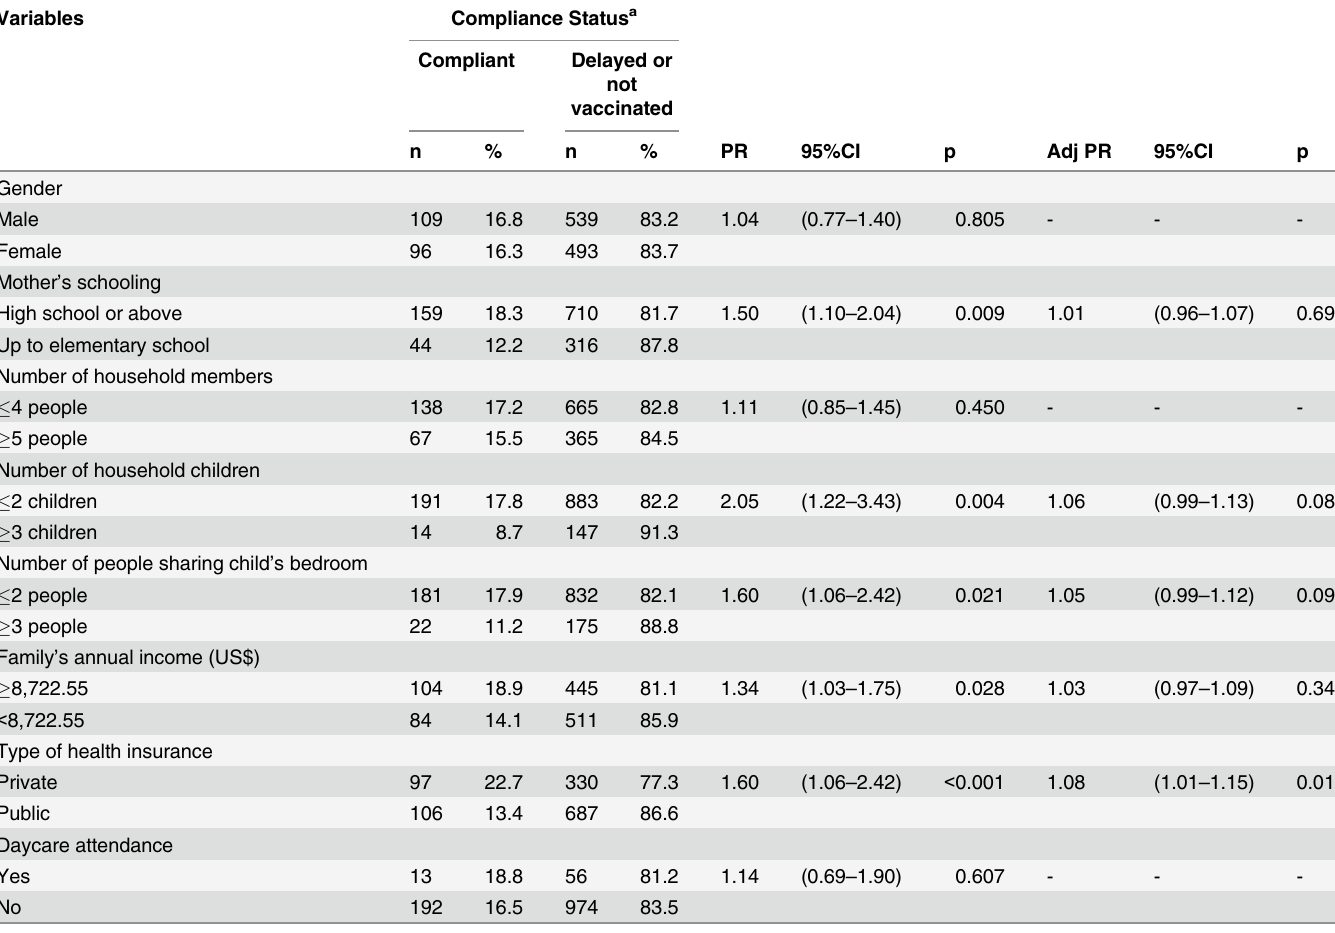
Table 4. Variables associated with compliance with recommended PCV10 schedules, 6 to 8 months after PCV10 introduction.